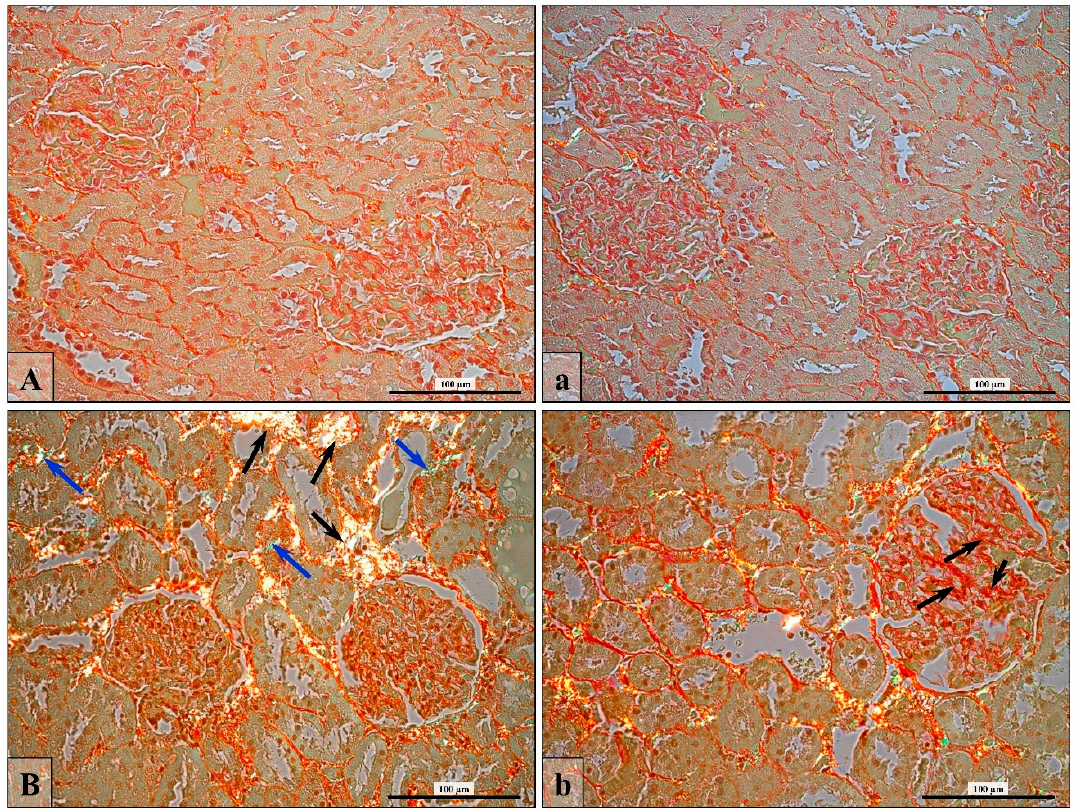
Figure 6. Visualization of collagen fibers type I—black arrows and type III—blue arrows) in control ( A , a ) and in finasteride-treated rats’ kidneys that exhibited well visible tubulointerstitial fibrosis ( B , arrows) and glomerulosclerosis ( b , black arrows). Sirius Red Staining, polarized microscopy. Scale bar: 100 µm.